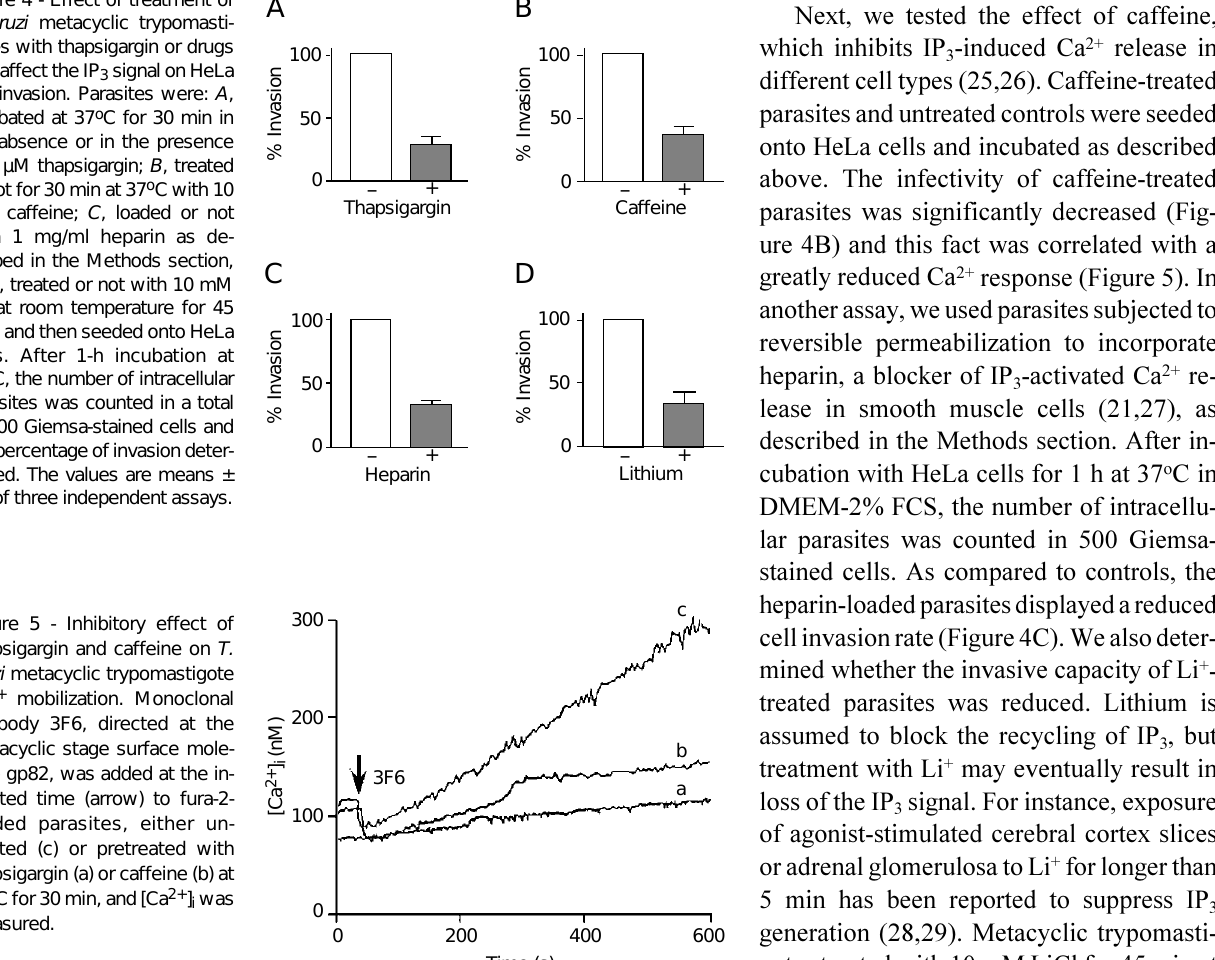
Figure 4 - Effect of treatment of T. cruzi metacyclic trypomasti- gotes with thapsigargin or drugs that affect the IP 3 signal on HeLa cell invasion. Parasites were: A , incubated at 37 o C for 30 min in the absence or in the presence of 1 µM thapsigargin; B , treated or not for 30 min at 37 o C with 10 mM caffeine; C , loaded or not with 1 mg/ml heparin as de- scribed in the Methods section, or D , treated or not with 10 mM Li + at room temperature for 45 min, and then seeded onto HeLa cells. After 1-h incubation at 37 o C, the number of intracellular parasites was counted in a total of 500 Giemsa-stained cells and the percentage of invasion deter- mined. The values are means ± SD of three independent